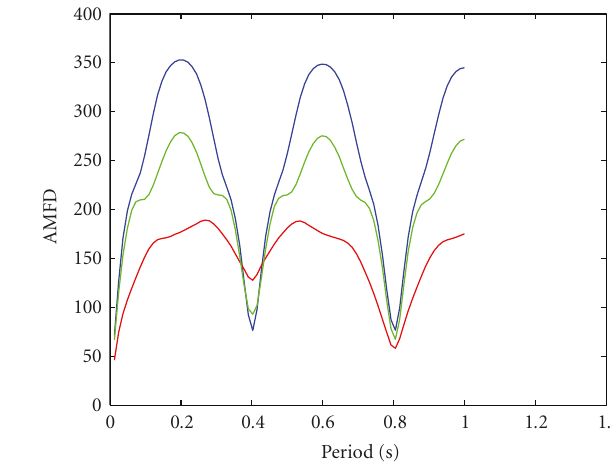
Figure 17: AMDF of accelerometer data during running.